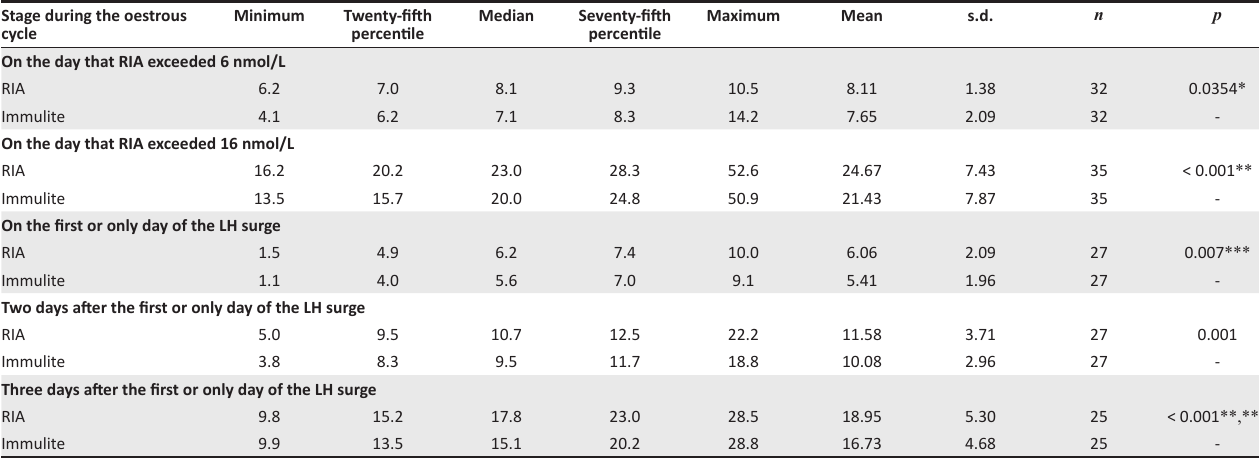
TABLE 1: Concentrations of progesterone measured with Coat-A-Count® radioimmunoassay and Immulite® 1000 LKPW1 at important times during oestrus in bitches. Stage during the oestrous